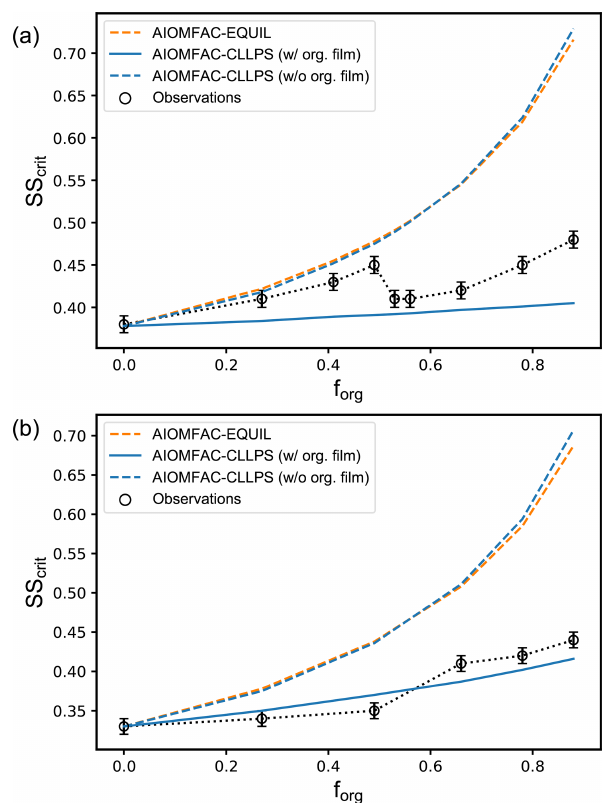
Figure 15. Comparison of critical supersaturation (SS crit ) data be- tween measurements and predictions from different AIOMFAC- based model variants. (a) Measured data ( ◦ , black line) and AIOM- FAC predictions (curves) of SS crit for cloud droplet activation of NaI particles coated/mixed with suberic acid for D dry = 50nm con- taining different volume fractions of suberic acid ( f org ). (b) Sim- ilar to panel (a) but with Na 2 CO 3 as inorganic component for D dry = 50nm. Experimental data by Davies et al.